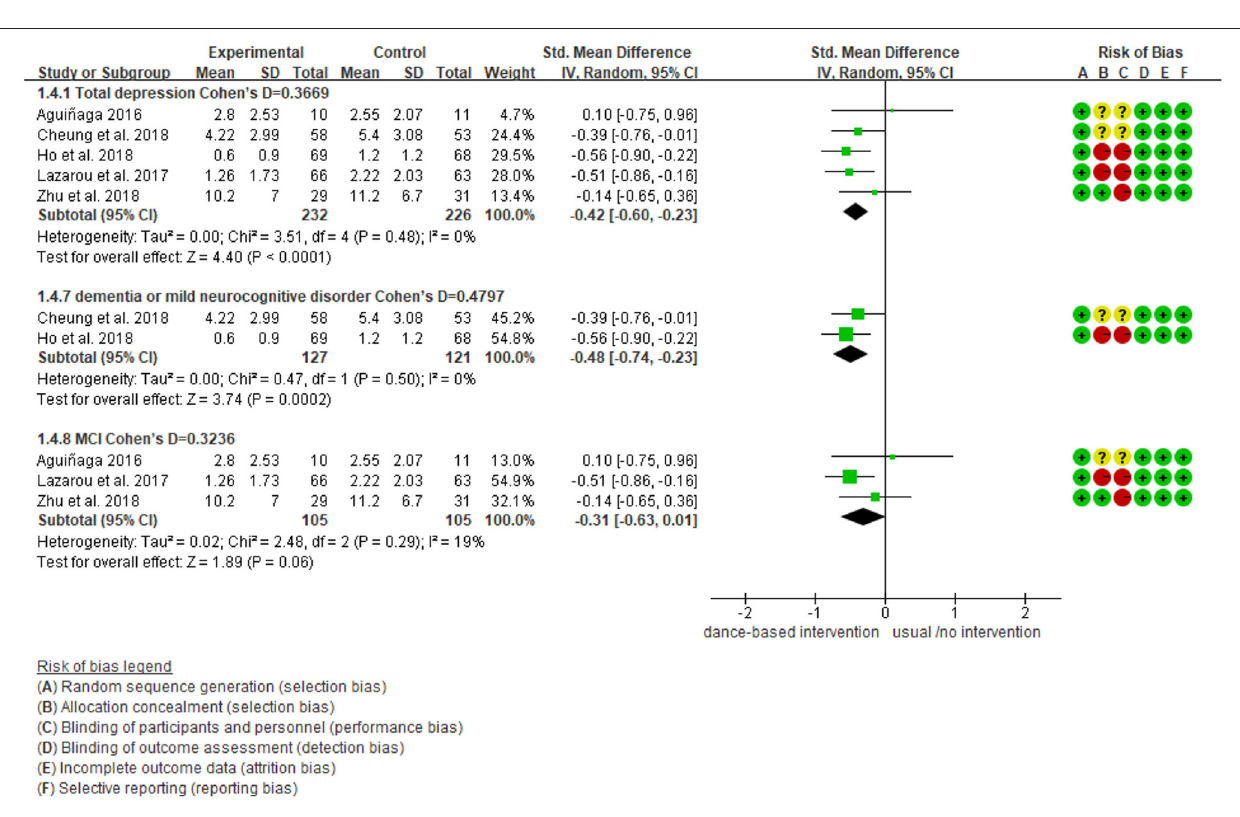
Frontiers in Psychology |